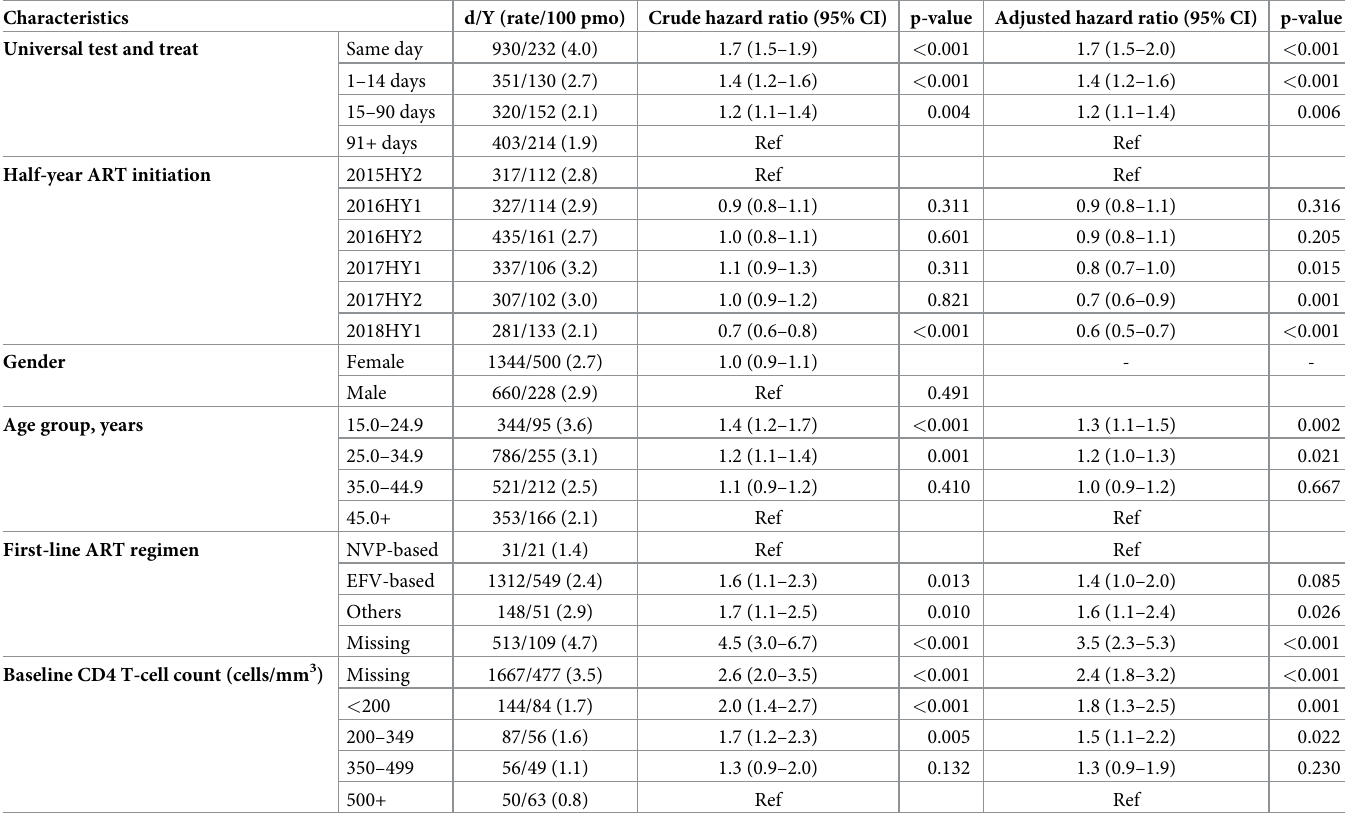
Table 3. Effect of universal test-and-treat uptake, defined as same day, 1–14 days, 15–90 days and 91+ days from a HIV diagnosis to combination antiretroviral therapy start on twelve months attrition, defined as lost to follow up or dead, amongst HIV infected adults captured in the national data warehouse in Kenya (2015HY2 to 2018HY1, N = 8592).